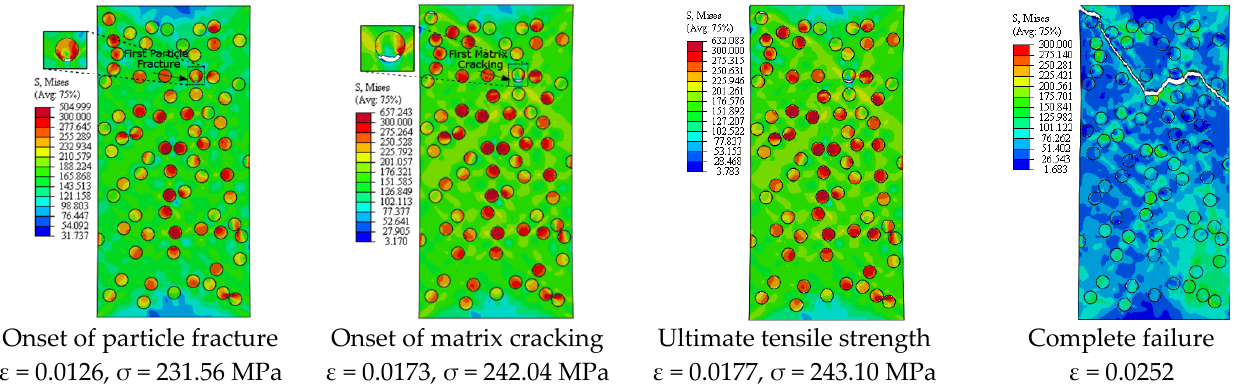
Figure 9. Failure propagation and von Mises stress distribution of A359/SiC composite at 15% VF (PS = 10 µm).